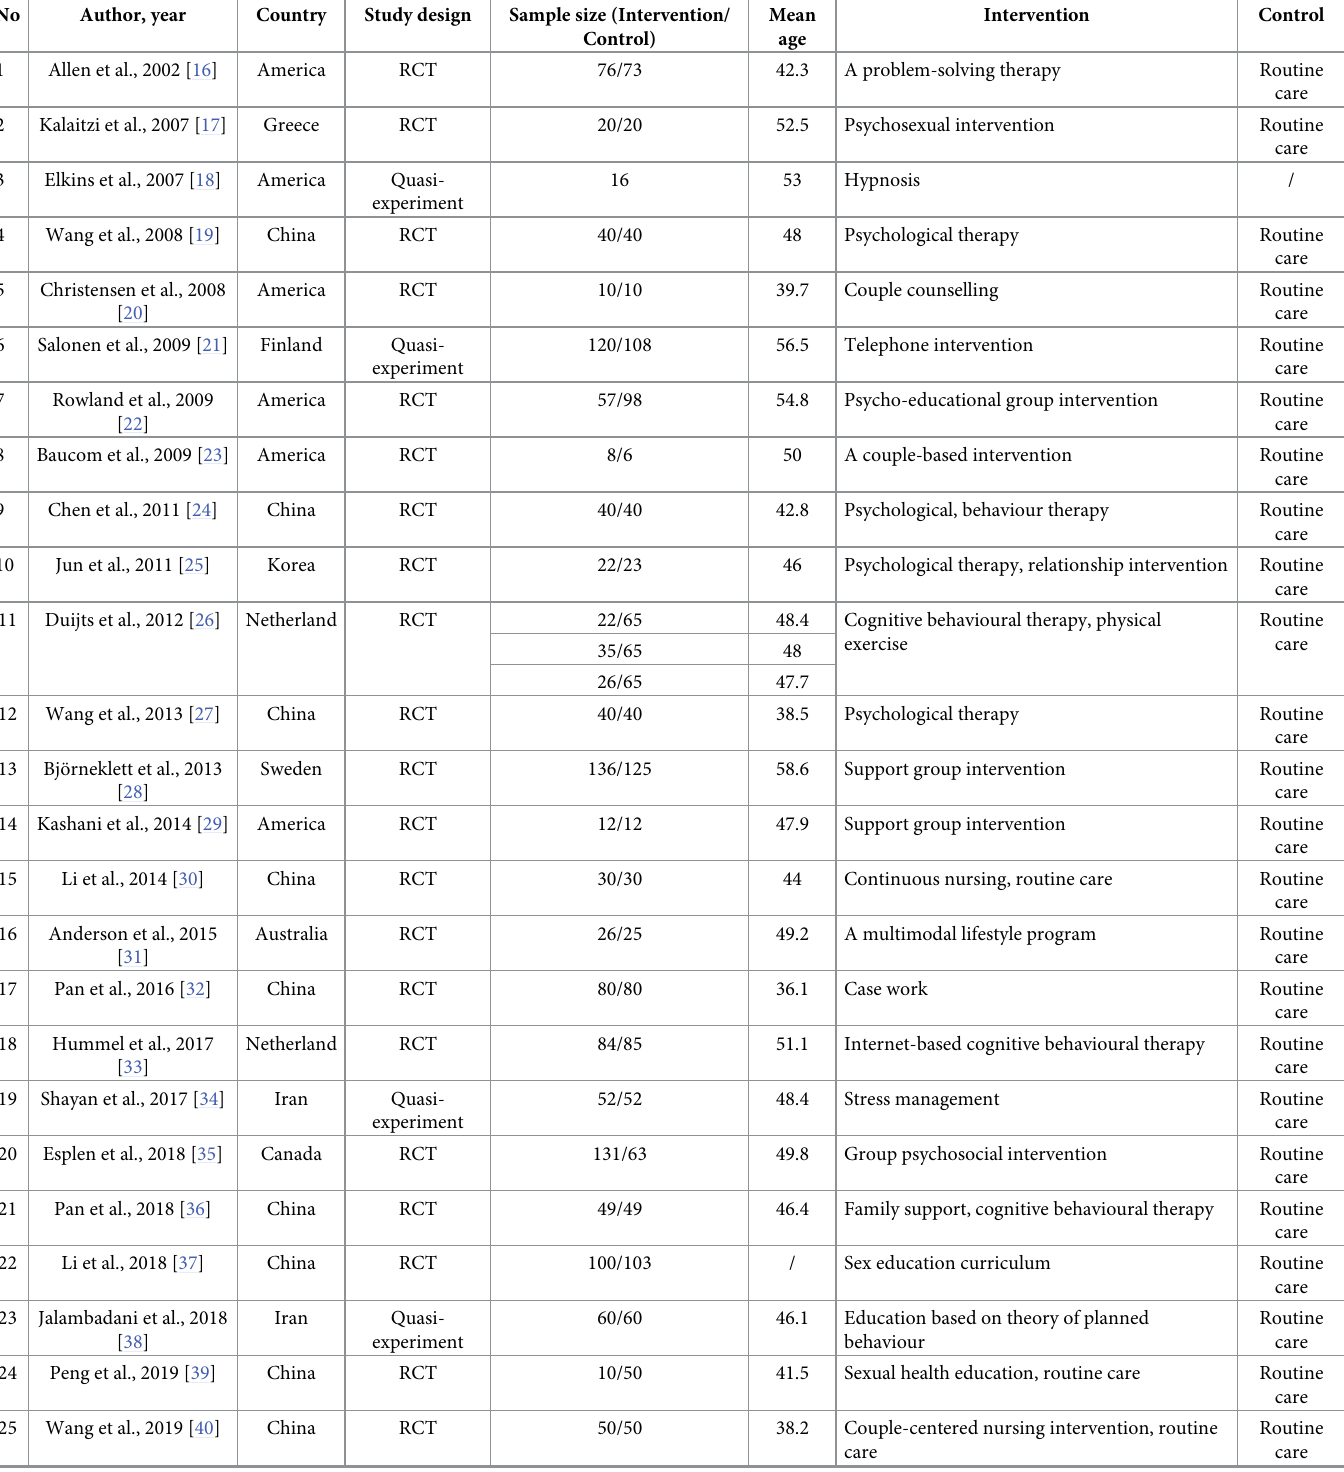
Table 1. Characteristics of included